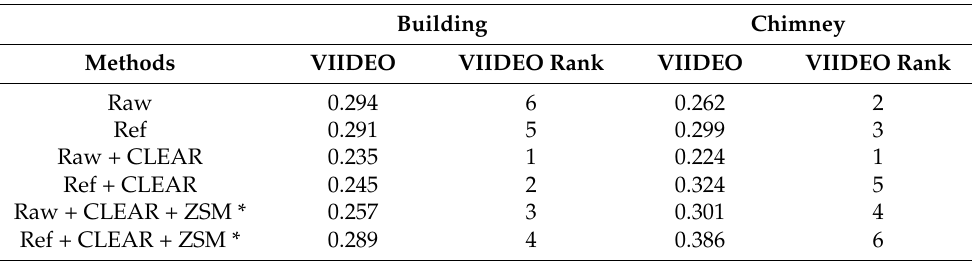
Table 6. VIIDEO score for all three sequences. (a) VIIDEO Metrics and Rankings for Building and Chimney Videos